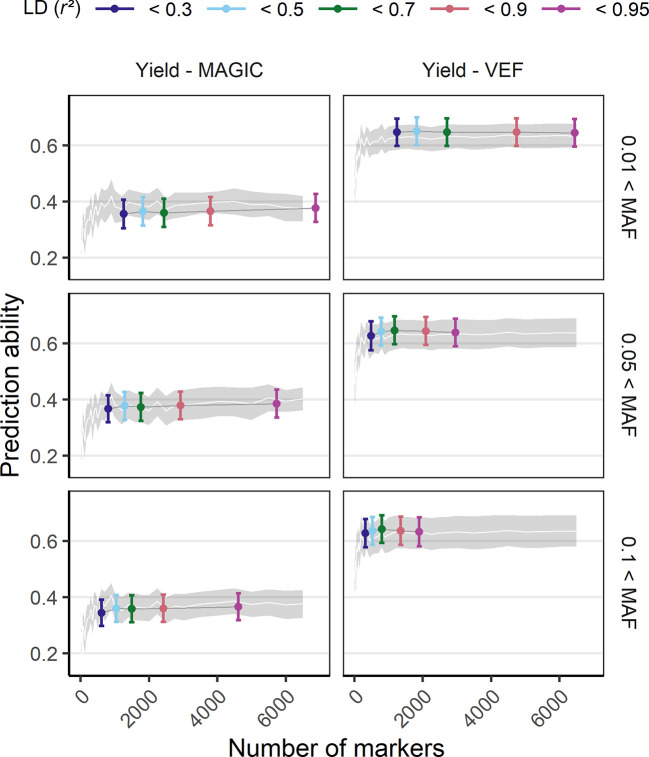
Genomic prediction abilities of seed yield in response to the number of utilized markers evaluated in the VEF and the MAGIC populations. The markers used for prediction were chosen either randomly (the white line and its gray stripe show the average prediction ability and its corresponding standard deviation) or based on LD and MAF parameters (colored ranges, the middle point and its error bar represent the average prediction ability and its standard deviation). The distribution of values in this plot corresponds to 100-fold cross validations with 70:30 training:validation population partitioning.